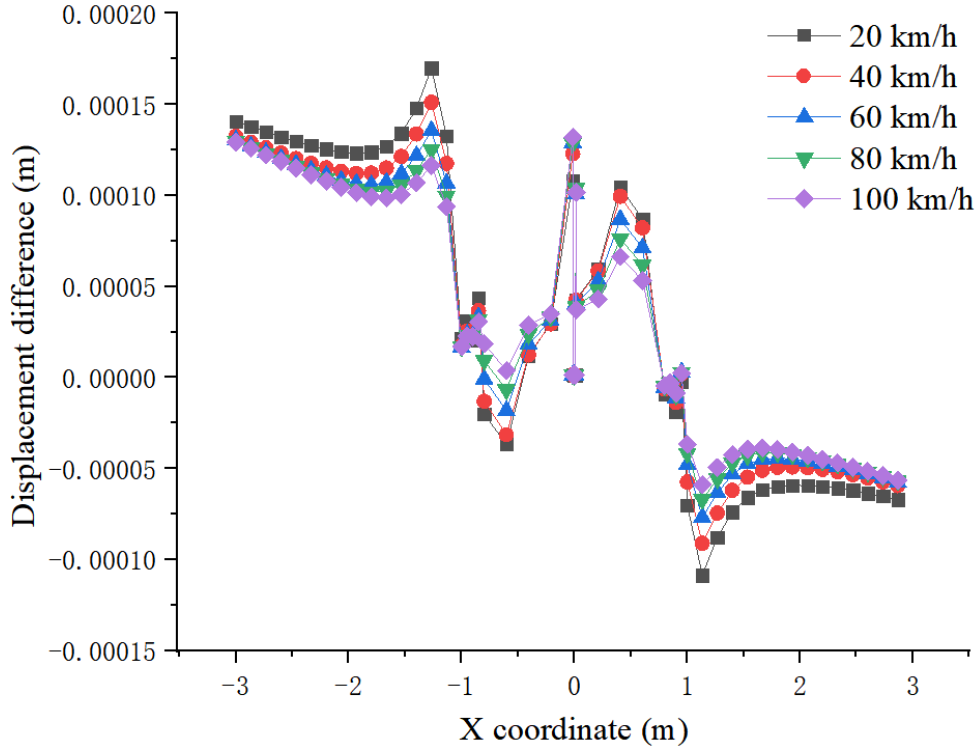
Figure 21. Distribution of displacement difference at 14.625 m under different vehicle speeds.